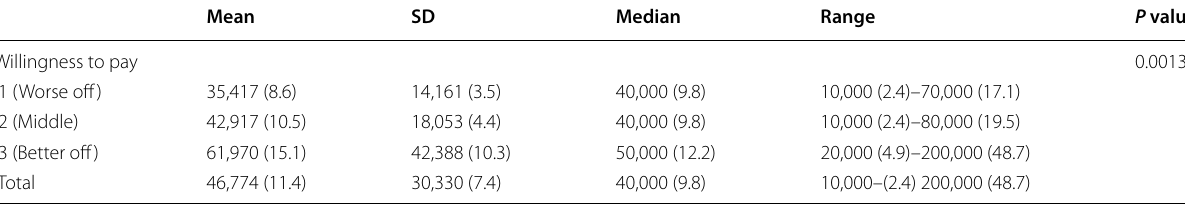
* Kruskal–Wallis test ( Χ 2